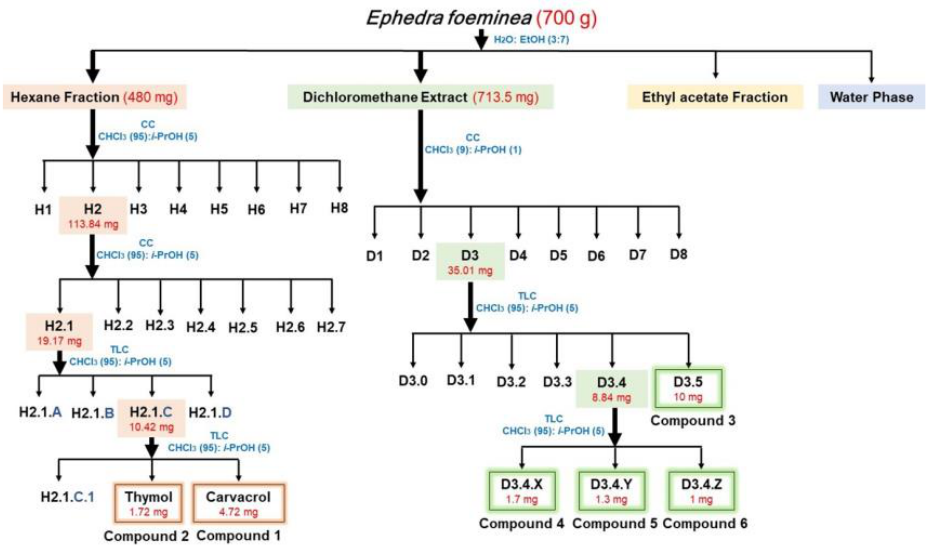
Figure 2. Schematic representation of the bioguided fractionation of extracts obtained from E. foeminea aerial parts.